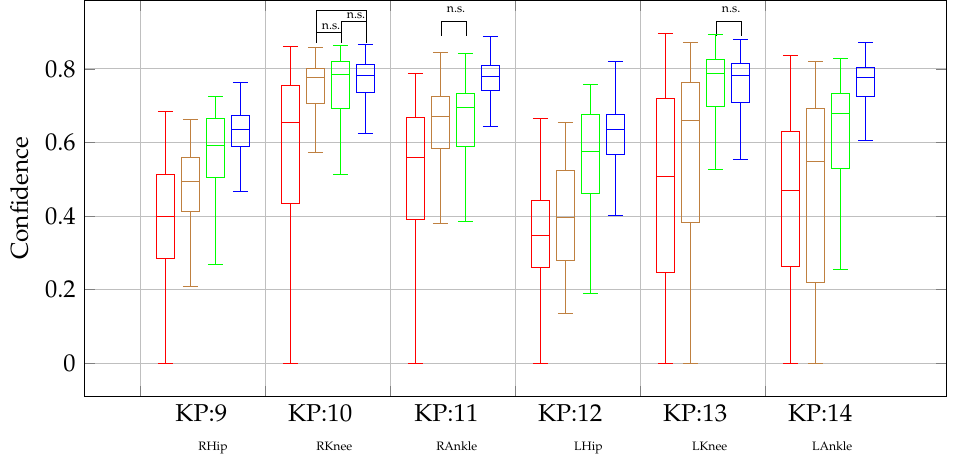
Figure 9. Confidence of detection of selected KP (keypoints)—side view, lower body. Camera views are shown in colour as follows: lying down ( N = 215); on the knees ( N = 92); sitting ( N = 145); and standing ( N = 297). All the other differences are statistically significant. Only differences that were not statistically significant (n.s.) are highlighted in the